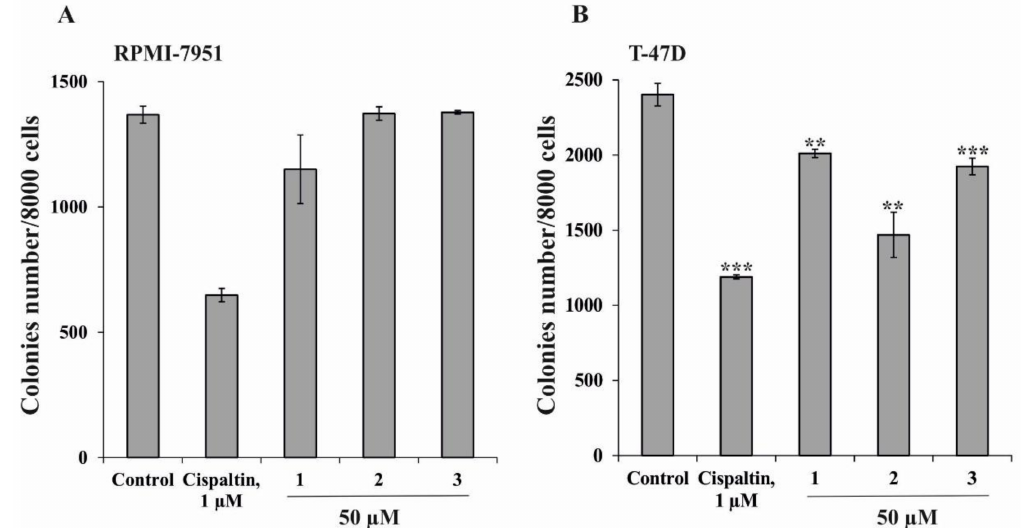
Figure 3. Effect of compounds 1 – 3 on colony formation of human melanoma RPMI-7951 ( A ) and breast cancer T-47D cells ( B ). The number of colonies were scored using a microscope «Motic AE 20» with the aid of the ImageJ software ( n = 9 for control and each compound, n —quantity of photos). The magnification of representative photos of colonies is × 10. The asterisks indicate a significant decrease in colony formation in cells treated with compounds compared with the non-treated cells (control) (** p < 0.01, *** p <